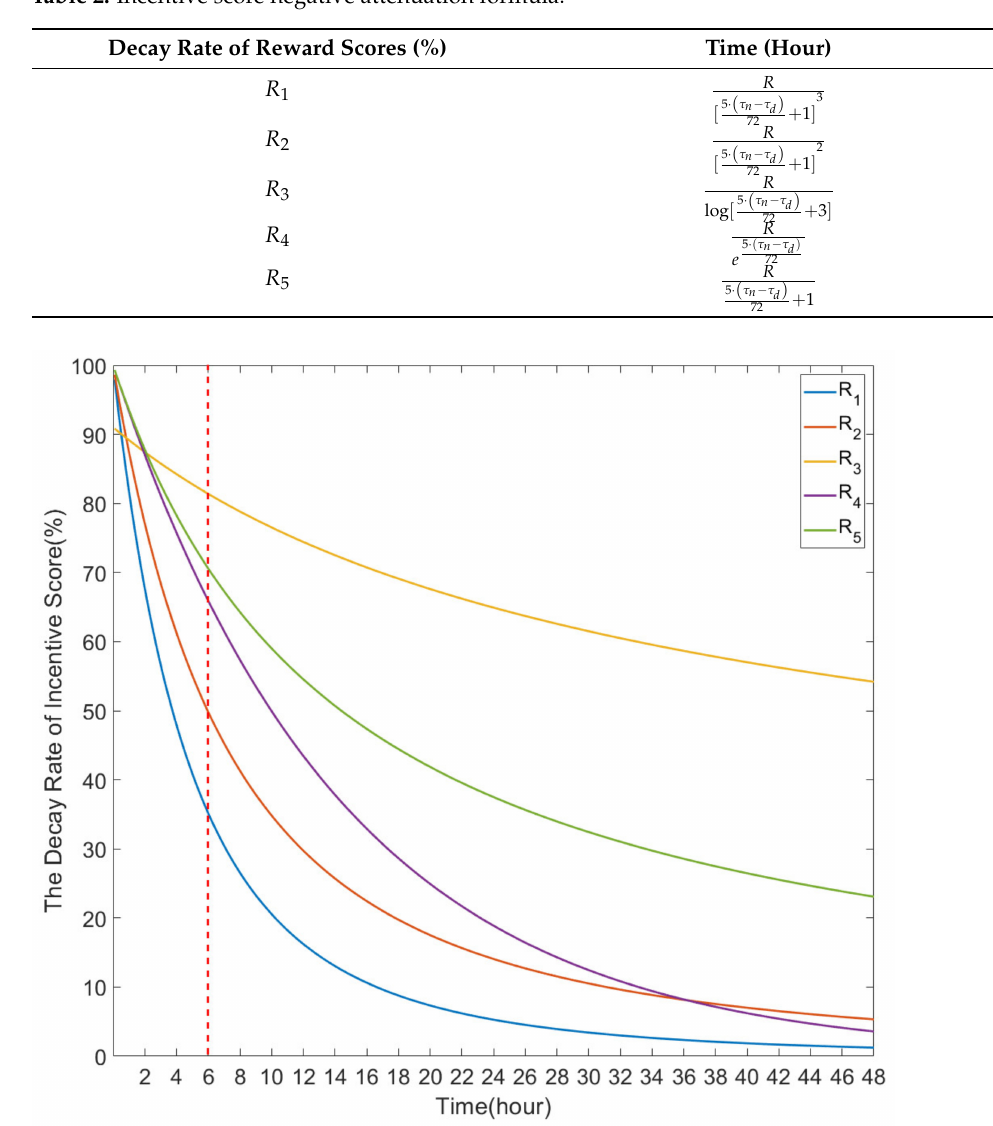
Figure 6. Comparison of negative decay of incentive